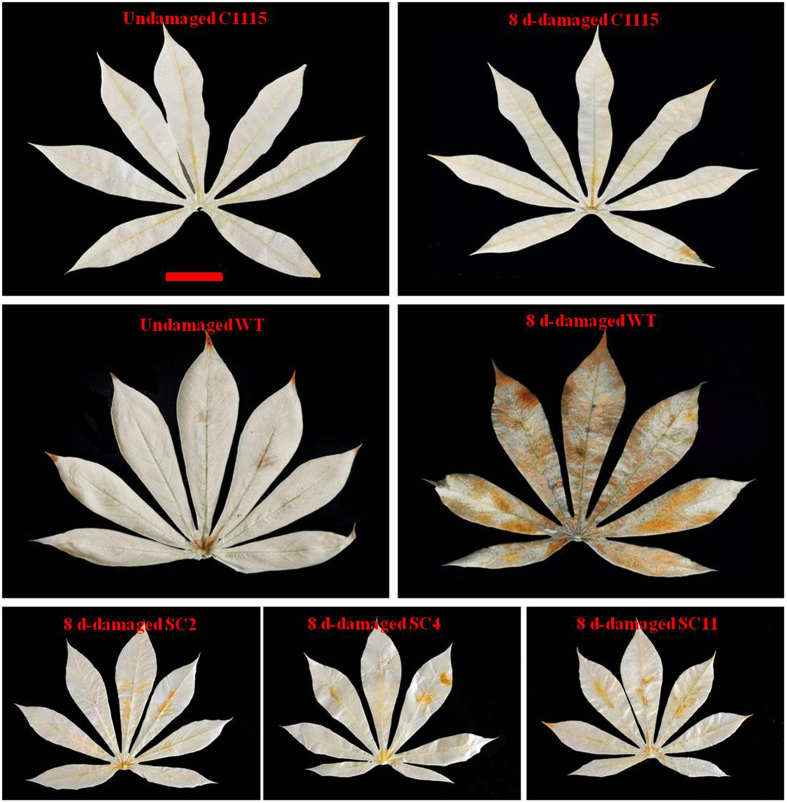
Enhanced tolerance to H2O2-mediated oxidative stress in different cassava plant leaves as detected by DAB staining.Bars = 5 cm.